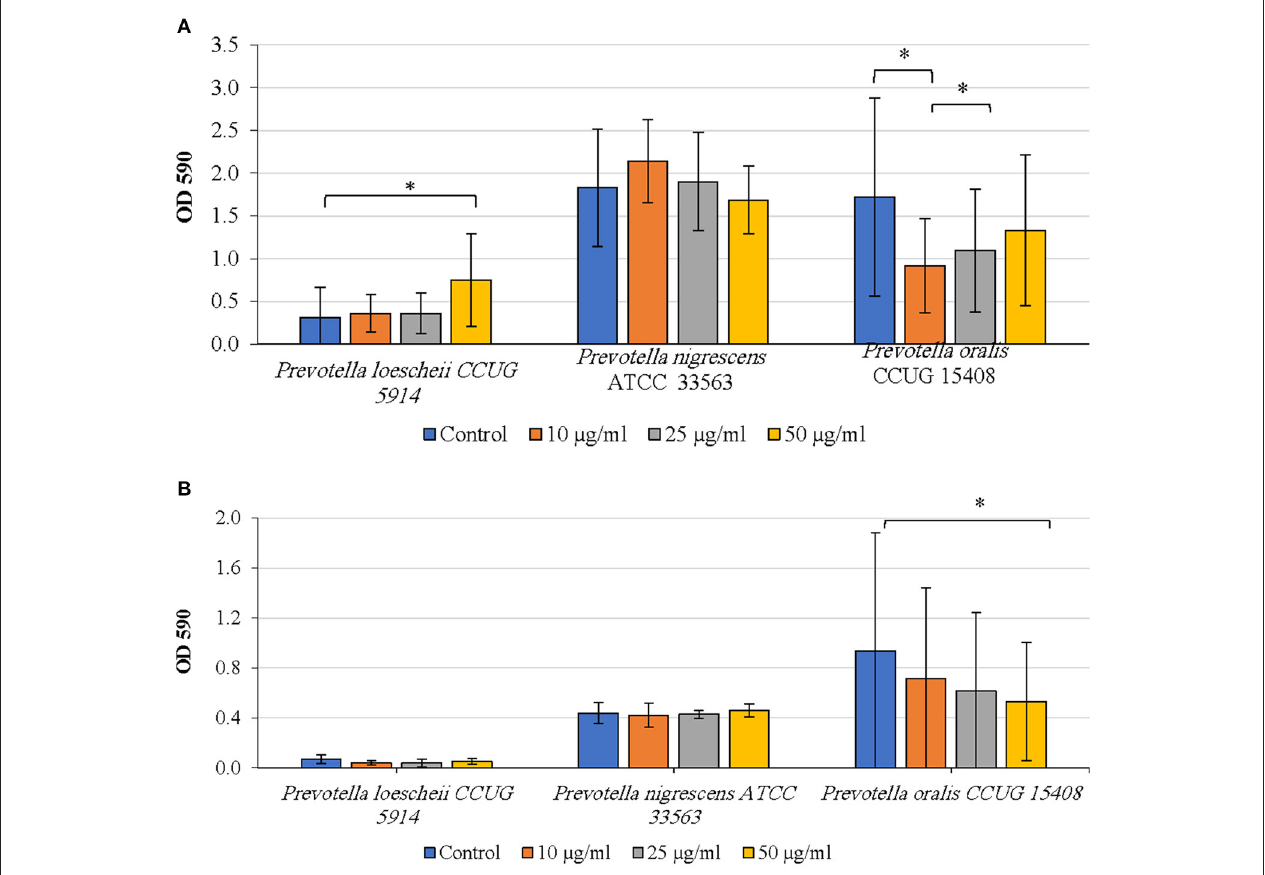
FIGURE 2 | (A) Inhibition of biofilm formation by proteinase. The effect of proteinase treatment on the initiation and development of biofilms was studied. Different concentrations of proteinase were added to the biofilm culture medium at the same time as the inoculum and incubated as described in the methods section. Biofilm mass was quantified using crystal violet technique. * P < 0.005 Mann Whitney. (B) Detachment of preformed biofilms by proteinase. The effect of proteinase treatment on the preformed biofilms was studied. Different concentrations of proteinase were added to the biofilm culture medium at the same time as the inoculum and incubated as described in the methods section. Biofilm mass was quantified using crystal violet technique. * P < 0.005, Mann